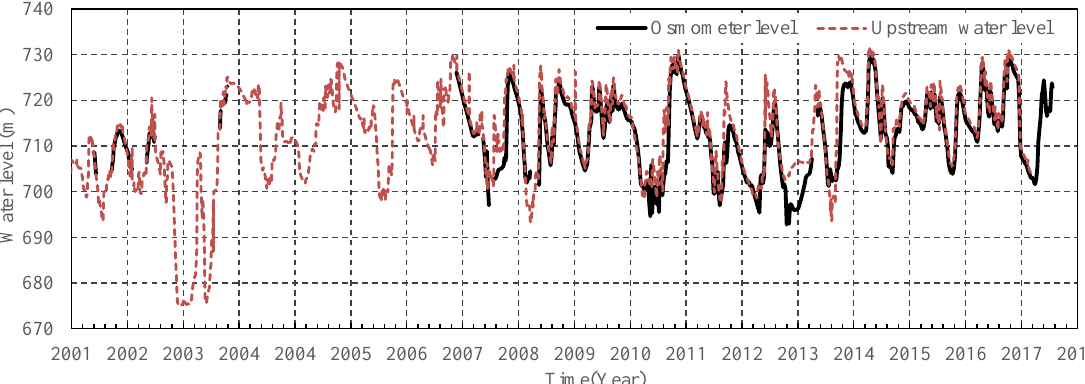
Figure 6. The hydrograph of the upstream water level and osmometer level of B10.